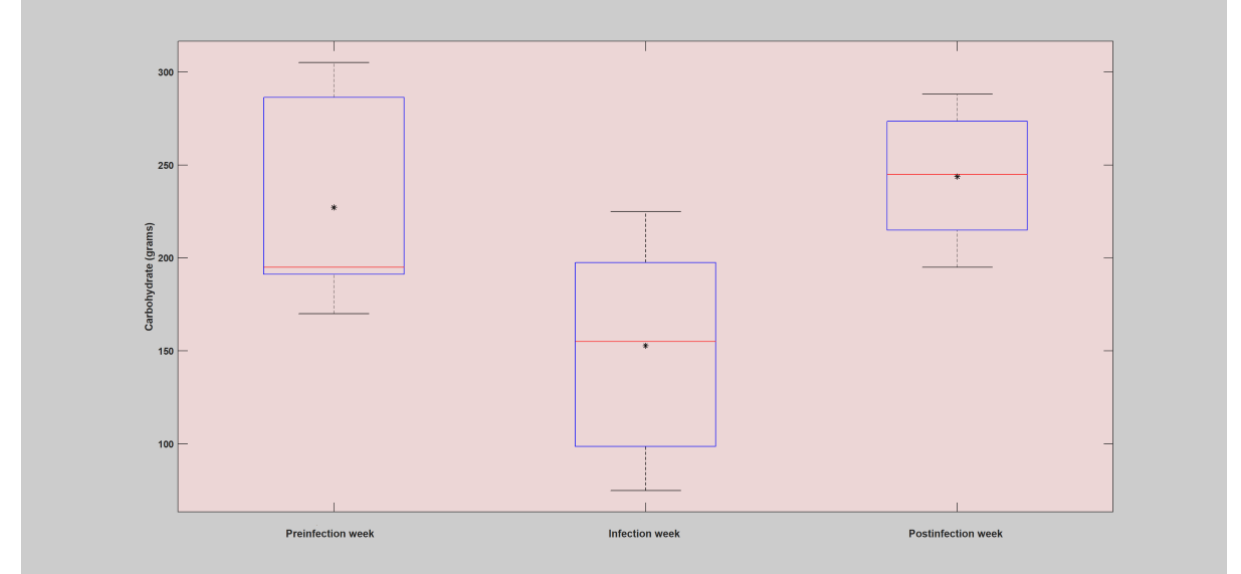
Figure 5. Analysis of total carbohydrate (grams) intake during preinfection week, infection week, and postinfection week based on the first case of infection (flu). The asterisk shows the mean value, and the red line depicts the median value for the week.